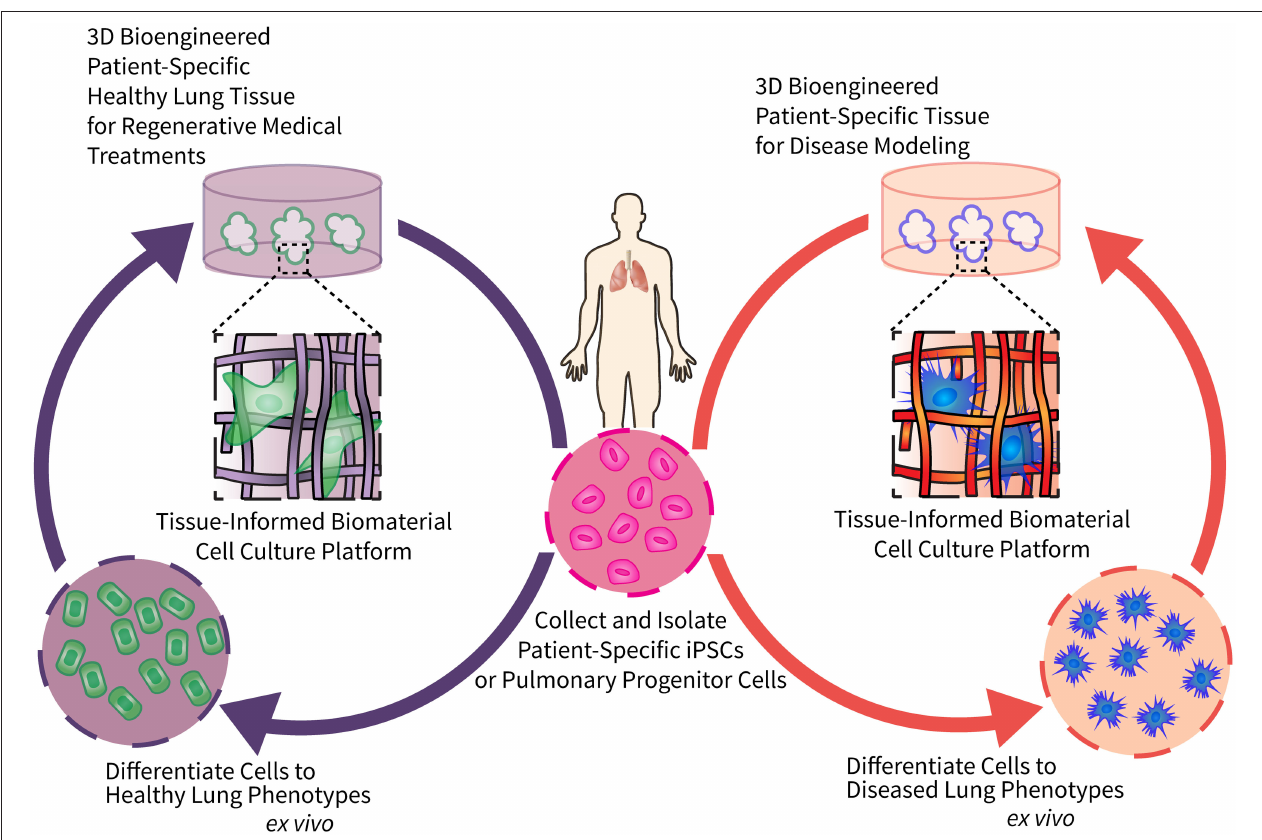
FIGURE 1 | Engineering tissue-informed biomaterials to advance pulmonary regenerative medicine and model respiratory disease. This schematic illustrates the potential for tissue-informed biomaterials to advance pulmonary regenerative medicine through two complementary pathways: (1) by using tissue-informed biomaterial cell culture platforms to differentiate patient-specific stem cells into healthy, implantable lung cells and tissue (left); and (2) engineering biomaterial-based platforms to induce differentiation of these same patient-specific stem cells into diseased phenotypes for disease modeling and evaluation of precision medical treatments